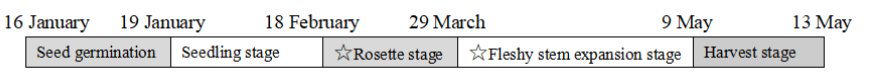
Figure 2. The division of growth stage for the lettuce ( ☆ indicates that at this stage, the lettuces were treated with different lower limits of drip irrigation).